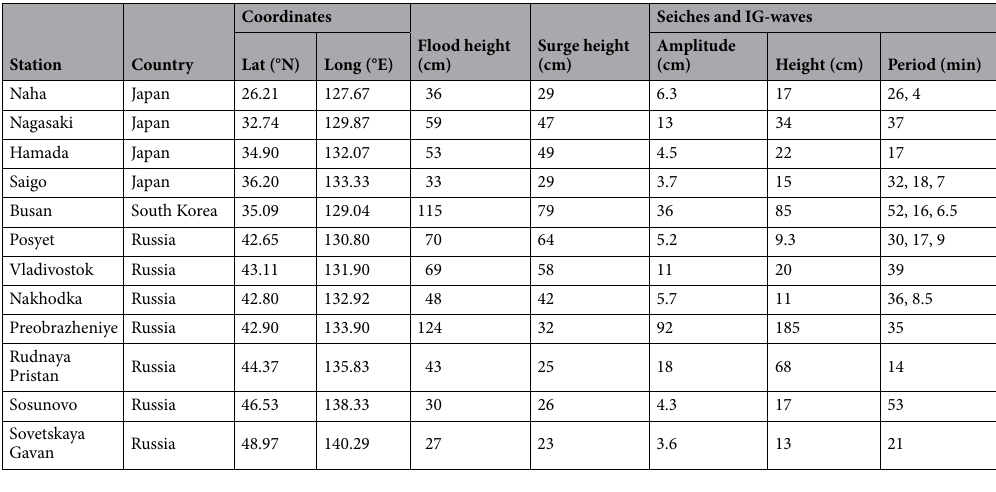
Table 1. List of tide gauges and observed surge and seiche (including IG-waves) parameters for the corresponding records during the 2020 Typhoon Maysak on the coasts of Japan, South Korea, and Russia. “Flood height” (FH) is the absolute displacement height relative to the mean sea level (MSL); “surge height” (SH) is the height of the storm surge solely above the MSL. The approach for the estimation of these parameters is shown in Fig. 3a for Preobrazheniye station. Location of the stations is shown in Fig.